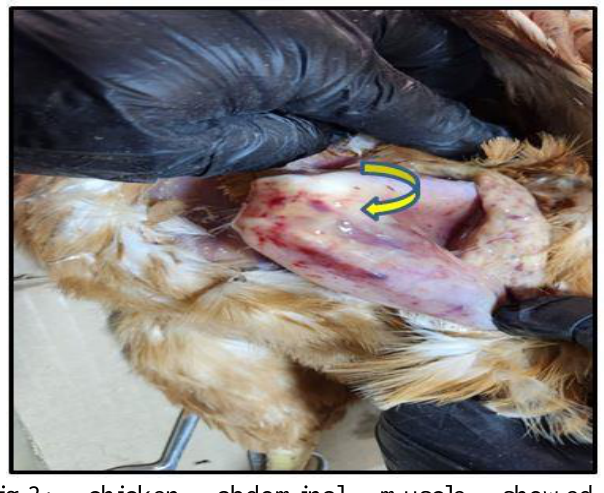
Fig.3: chicken abdominal muscle showed